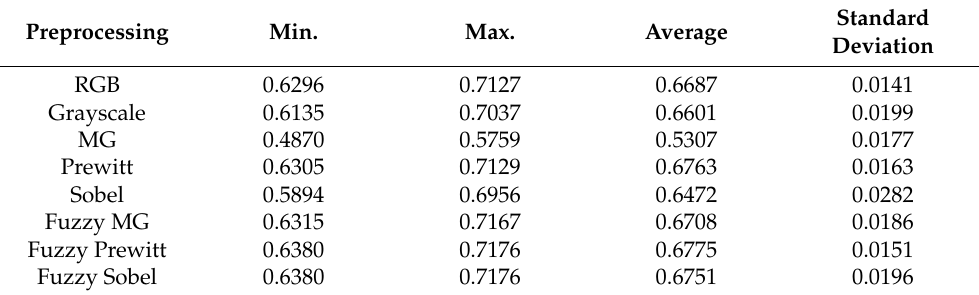
Table 6. Results of the CNN-I model.